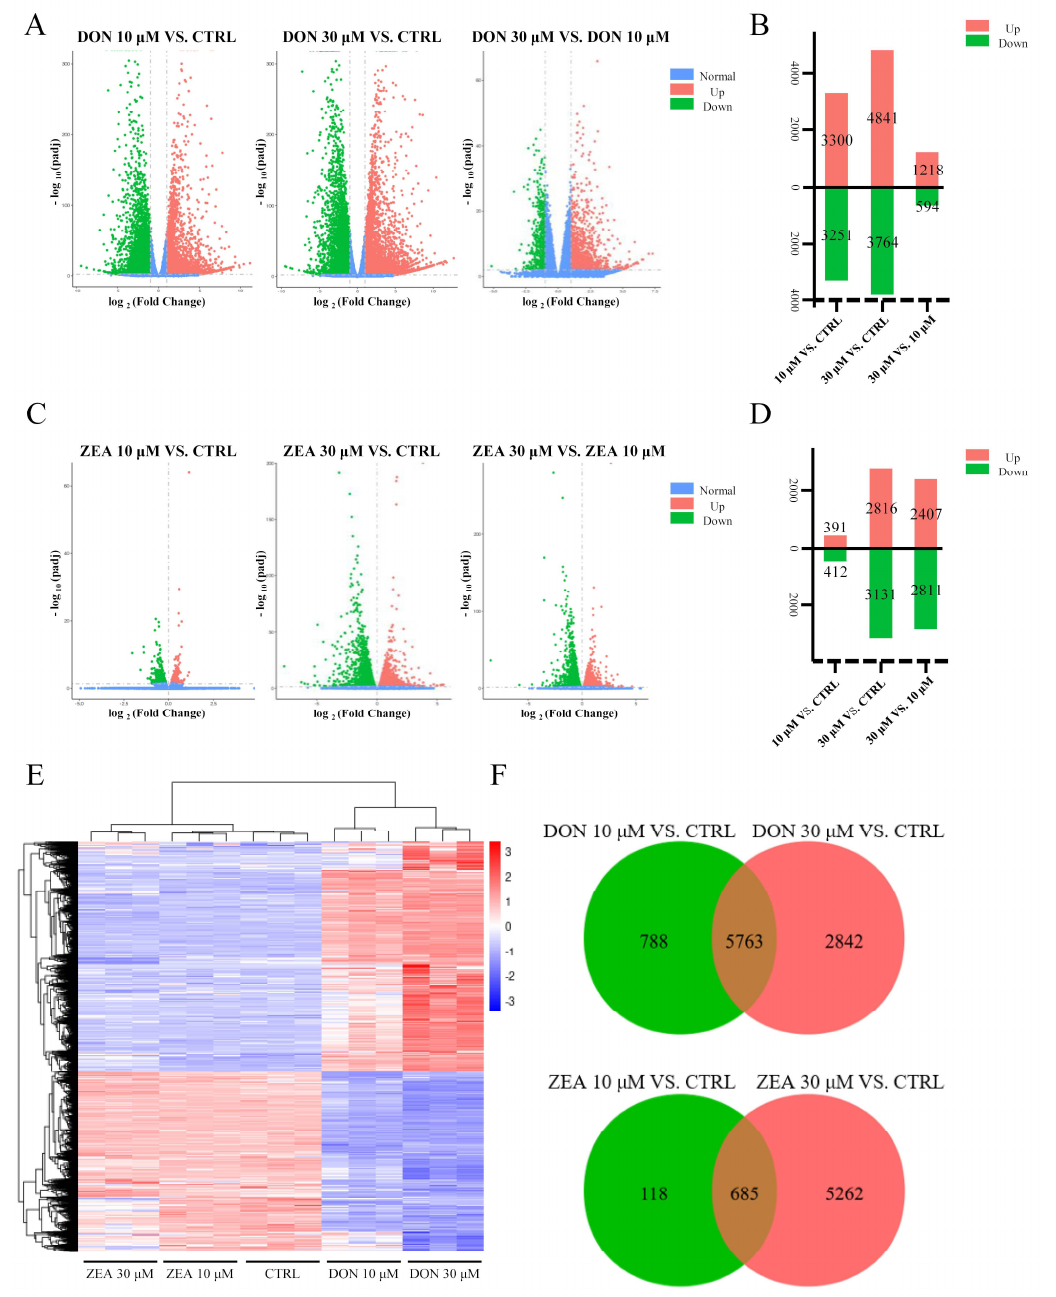
Figure 3. Gene expression profiles of SCs after DON and ZEA treatment. ( A ) Scatterplot of gene expression after DON treatment; 10 µ M DON treatment group vs. Control group, 30 µ M DON treatment group vs. Control group, 30 µ M DON treatment group vs. 10 µ M DON treatment group. Green and red plots represent differentially expressed genes. ( B ) Comparison of DEGs among the control, 10 µ M and 30 µ M DON-treated groups. ( C ) Scatterplot of gene expression after ZEA treatment; 10 µ M ZEA treatment group vs. control group, 30 µ M ZEA treatment group vs. control group, 30 µ M ZEA treatment group vs. 10 µ M ZEA treatment group. Green and red plots represent differentially expressed genes. ( D ) Comparison of DEGs among the control, 10 µ M and 30 µ M ZEA treated groups. ( E ) Heatmap indicating the group difference of DEGs in the 10 µ M and 30 µ M DON and ZEA treated groups compared with the control group, and the repeatability within each group. The results are presented as the means ± SD. All experiments were repeated at least three times. ( F ) Venn diagram showing the differential expression of 9393 and 6065 genes in the DON and ZEA treated groups compared to the control groups.